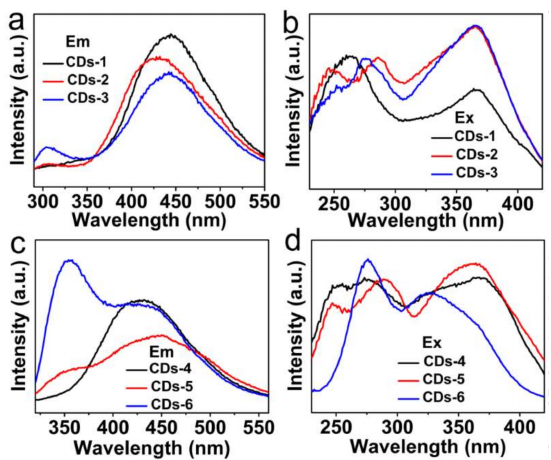
Figure 3. ( a , b ) PL emission (Em) spectra ( λ ex = 280 nm) and excitation (Ex) spectra ( λ em = 445 nm) of CDs-1, CDs-2, and CDs-3; ( c , d ) PL emission (Em) spectra ( λ ex = 300 nm) and excitation (Ex) spectra ( λ em = 445 nm) of CDs-4, CDs-5, and